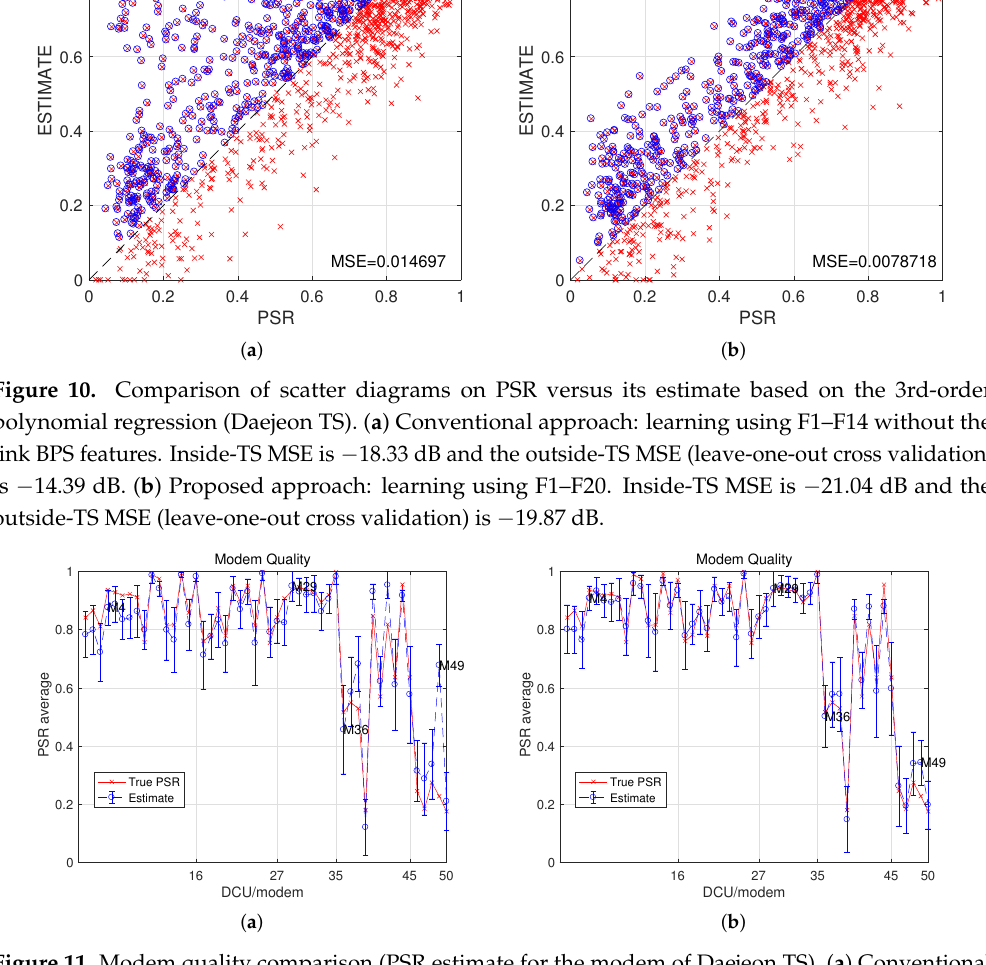
Figure 11. Modem quality comparison (PSR estimate for the modem of Daejeon TS). ( a ) Conventional approach: estimate designed excluding the link BPS features. ( b ) Proposed approach: estimate designed using the 20 BPS features as Figure 10. Modem M49 shows an improved precision due to employing the link